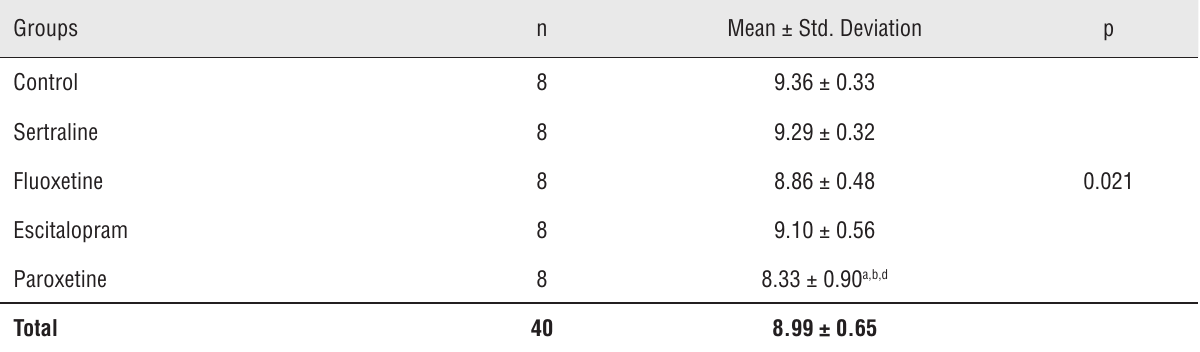
Table 2 - The spermatogenesis results according to Johnsen Score System in the testicular tissues of rats. Groups n Mean ± Std. Deviation p Control 8 9.36 ± 0.33